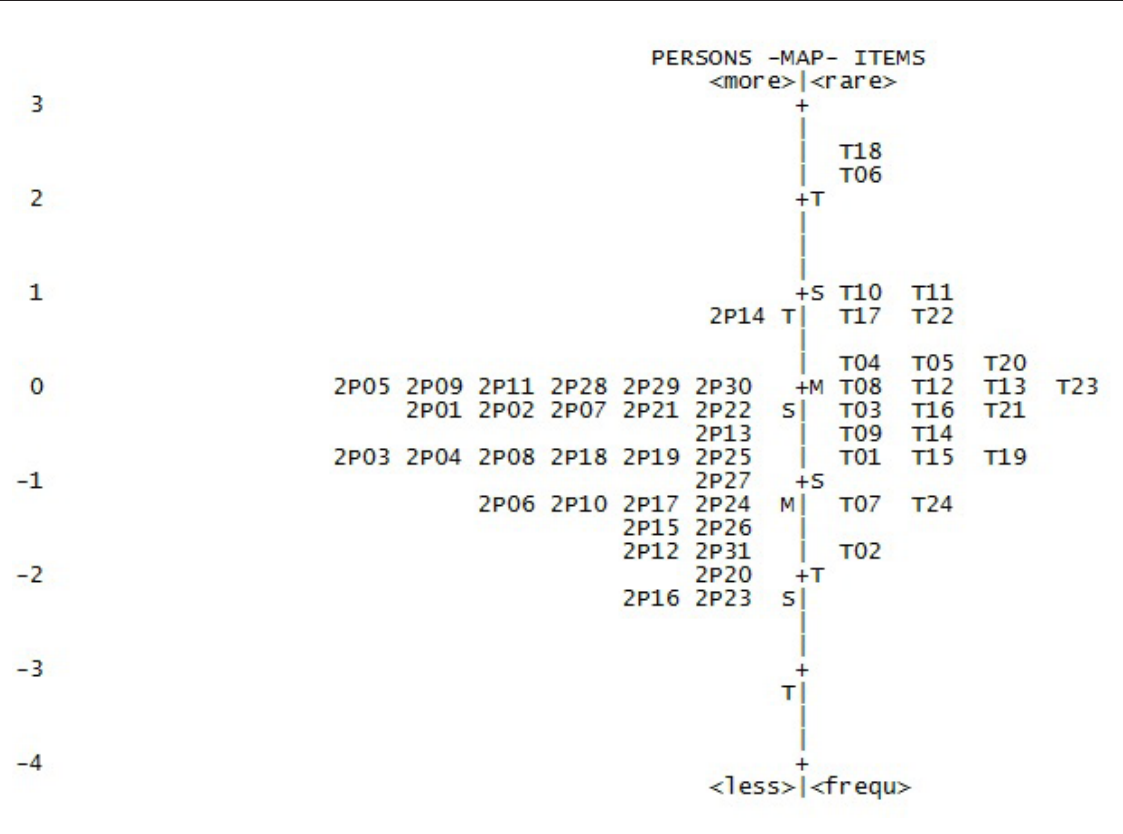
Person–item map showing Campus A students’ level of visual literacy plotted against order of difficulty of visualisation skills. The left-hand side shows level of visual literacy for students from Campus A; the right-hand side shows order and level of difficulty for the 24 visualisation